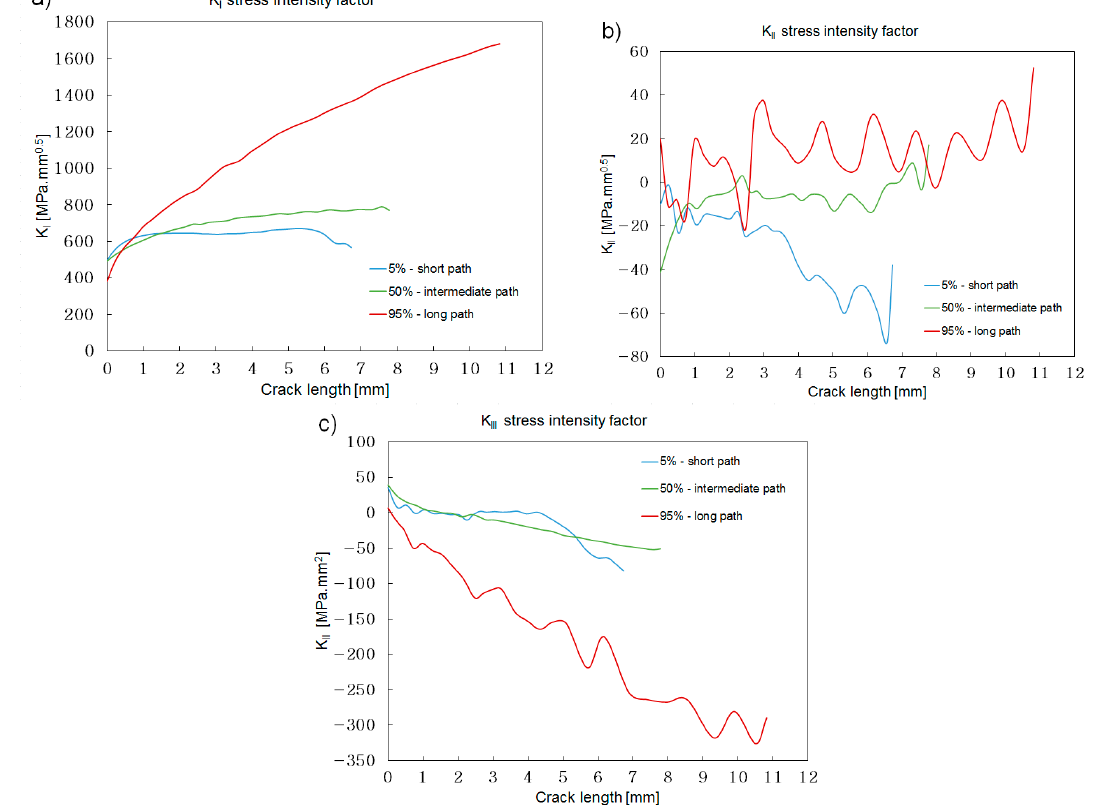
Figure 16. The 60° angle short flank. Stress intensity along the three crack paths selected: ( a ) K I ; ( b ) K II ; ( c ) K III .